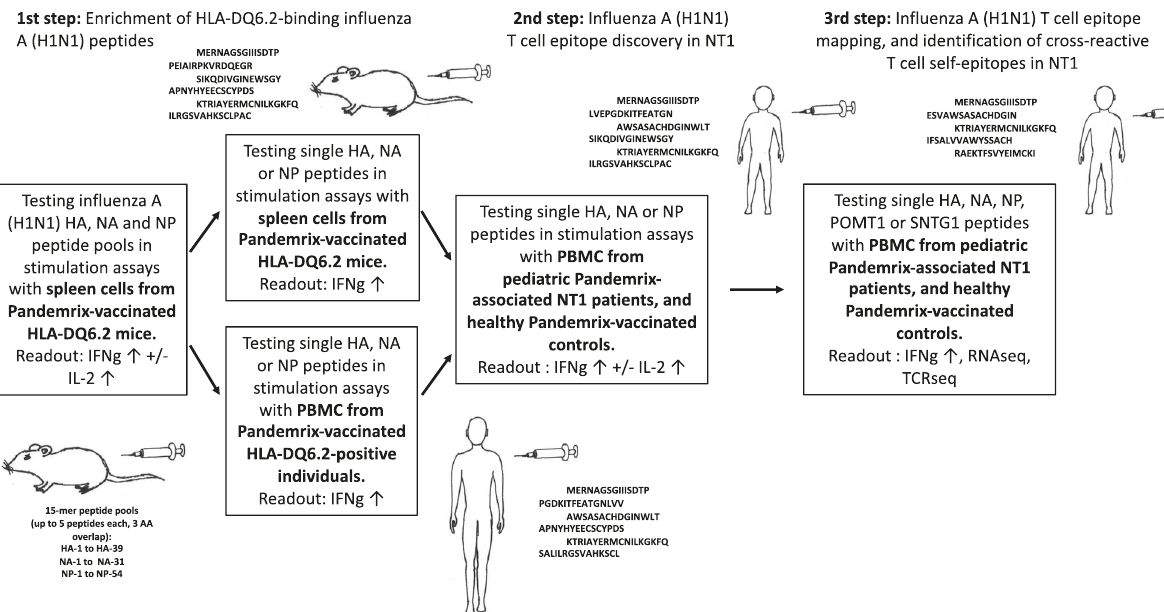
Fig. 1 Overall experimental study design for T-cell epitope discovery in Pandemrix-associated NT1. As a fi rst step, in fl uenza A (H1N1) virus HA, NA, and NP peptide T cell recognition was tested with spleen cells from Pandemrix-vaccinated HLA-DQ6.2 mice, restimulated with pools of 5 peptides each (15- mers). Pools that stimulated IFN - γ or IL-2 expression were broken up, and single peptides tested either with spleen cells from additional Pandemrix- vaccinated HLA-DQ6.2 mice, or PBMC from Pandemrix-vaccinated HLA-DQB1*0602 positive individuals. As a second step, recognition of single peptides was then tested with PBMC from pediatric Pandemrix-associated NT1 patients, and healthy Pandemrix-vaccinated controls. As a third step, in fl uenza A (H1N1) T cell peptides that showed increased stimulation of IFN - γ or IL-2 secretion in patients vs. controls were validated and mapped. Cross-reactive T cell self-epitopes were predicted by BLAST against human proteome, and recognition tested with PBMC from pediatric Pandemrix-associated NT1 patients, and healthy Pandemrix-vaccinated